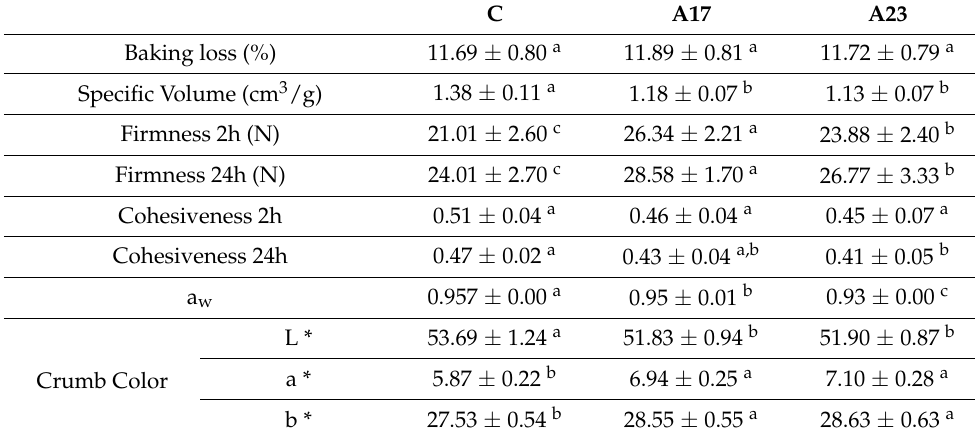
Table 4. Physical characteristics of GF breads: (C) control, without apple flour, (A17) with 17%, and (A23) with 23% apple flour